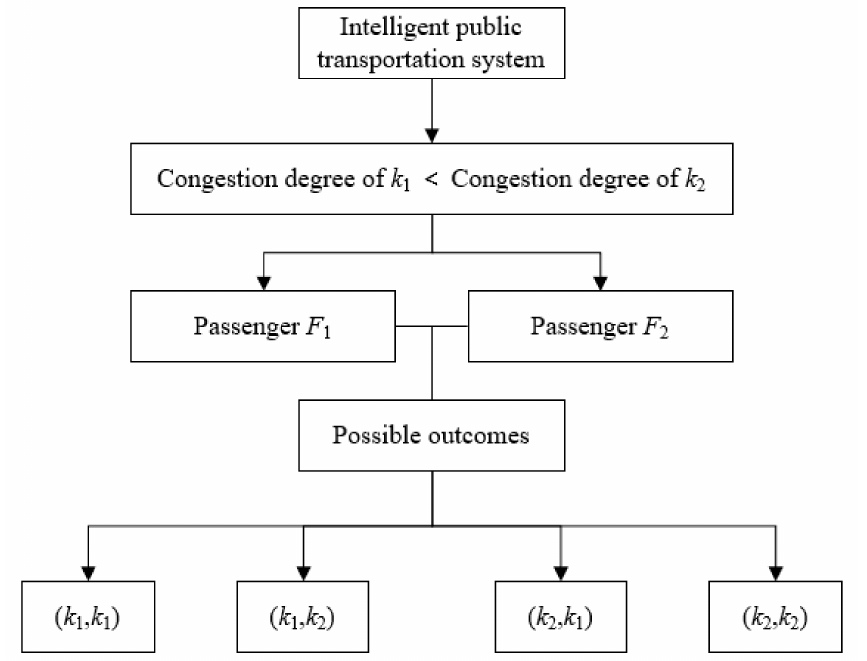
Figure 1. Combination of bus choices among